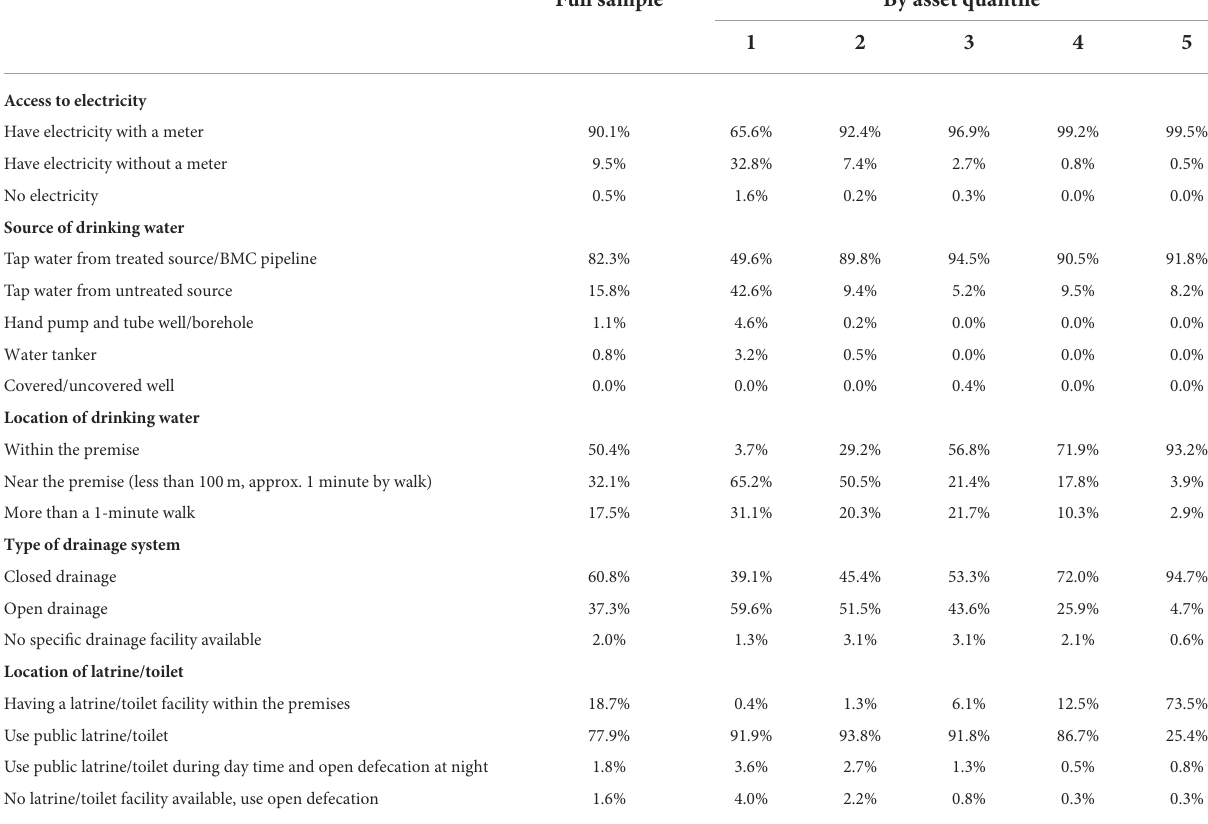
TABLE 6 Descriptive statistics (access to public